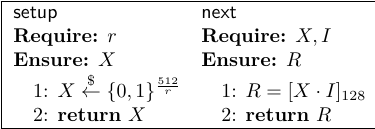
Figure 13: RES ( F ): A Secure